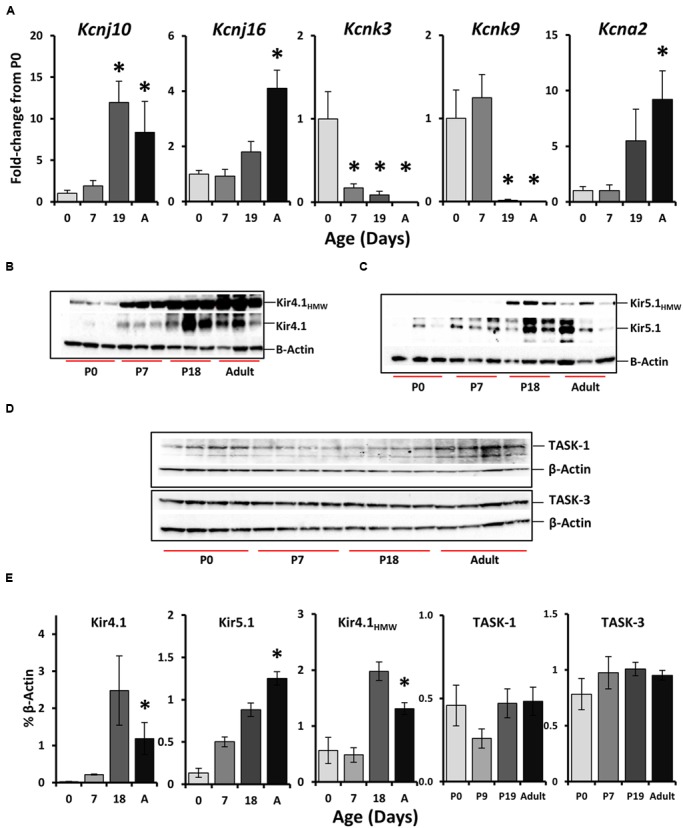
Age-related changes in the expression of select K+ channels the rostral medullary raphe. (A)
Kcnj10, Kcnj16, Kcnk3, Kcnk9, and Kcna2 gene expression patterns across age (P0, 7, 19, and adult) within the rostral raphe (∗P < 0.05 vs. P0 by one-Way ANOVA). Western blots from raphe tissues collected from different ages showed increases in both a high molecular weight band (∼250 kDa) Kir4.1HMW and expected (42.5 kDa) Kir4.1 bands (B), Kir5.1HMW (∼250 kDa) and expected (48 kDa) Kir5.1 bands (C), and TASK-1 (45–65 kDa) and TASK-3 (45 kDa) (D) with respective quantification normalized to β-actin (E; ∗P < 0.05 vs. P0 by one-way ANOVA). Note that the quantification for Kir5.1 protein in (E) was from two blots from P0 (n = 3), P7 (n = 4), P18 (n = 6), and adult (n = 3), but only one is shown in (C).